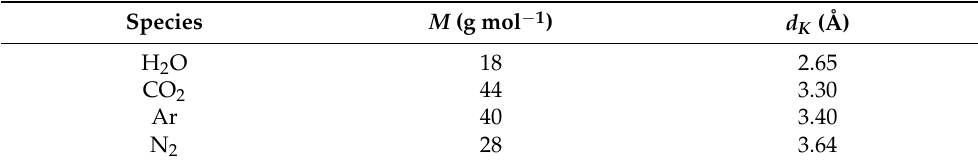
Table 1. Molecular weight ( M ) and kinetic diameter ( d K ) of the adsorptives used for adsorption experiments (water, carbon dioxide, nitrogen, [17]) and for the common adsorptive argon [16].